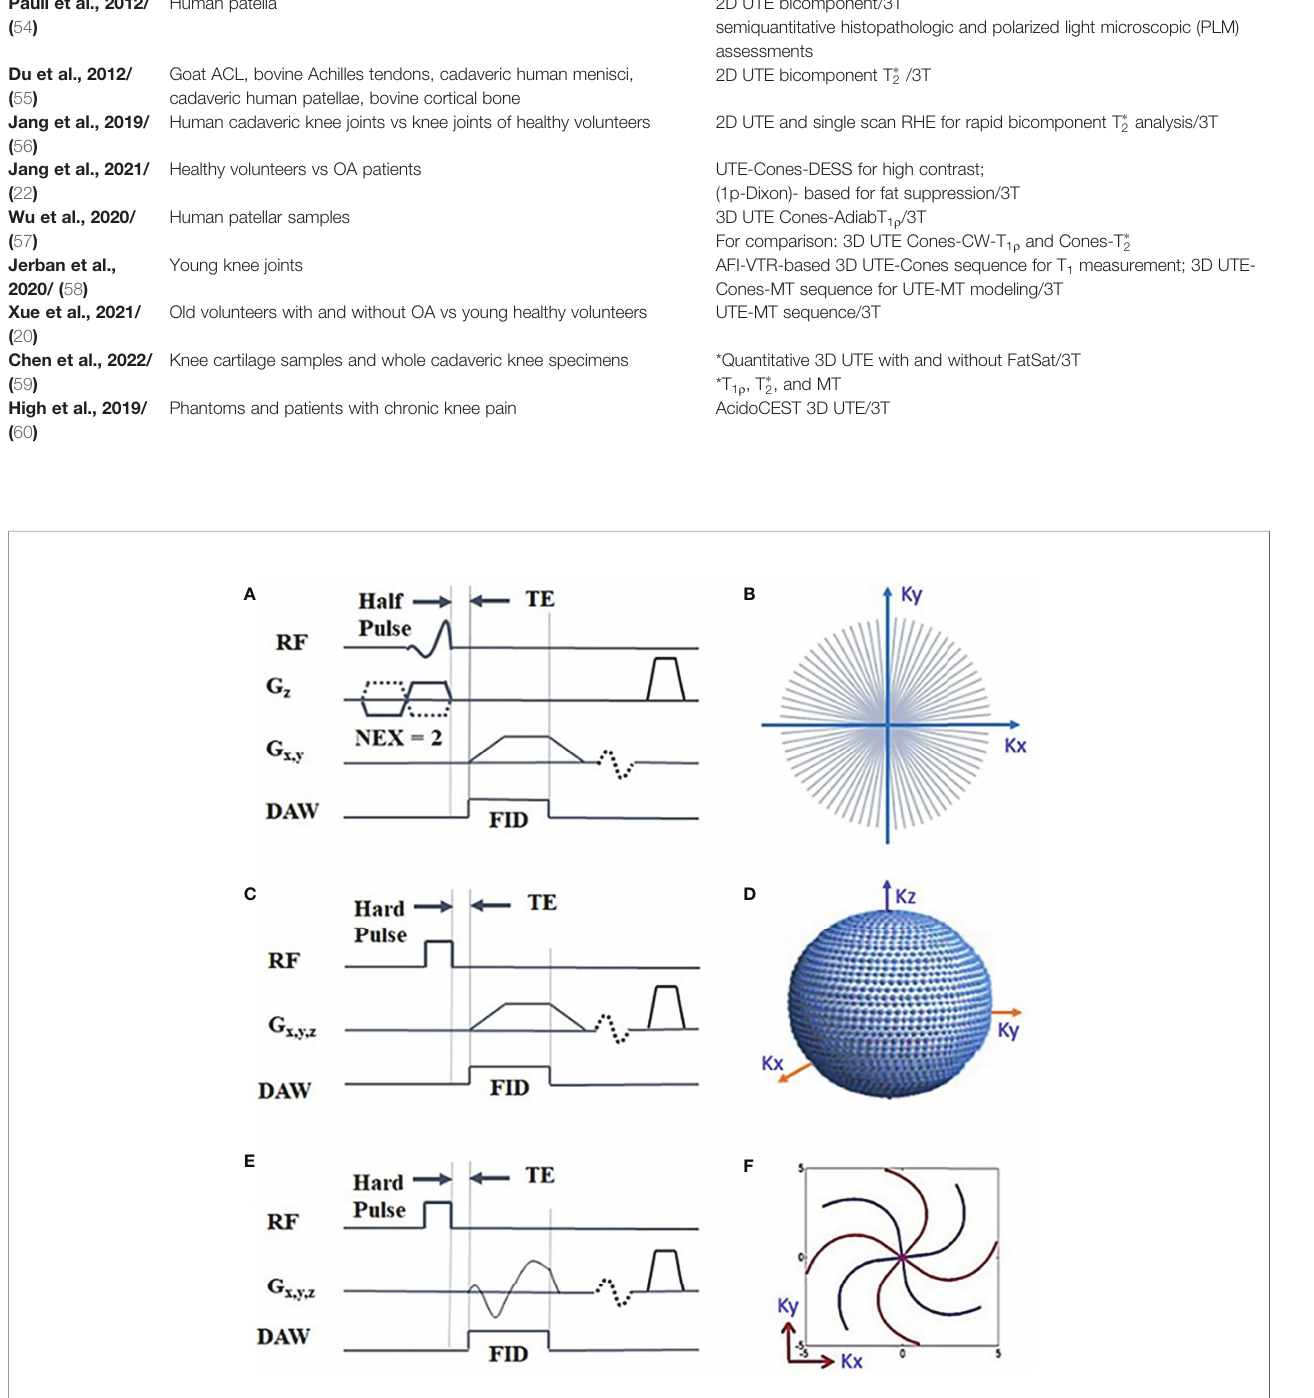
FIGURE 2 | Three representative UTE pulse sequence diagrams: 2D UTE sequence with a slice-selective half radiofrequency (RF) pulse excitation followed by 2D radial ramp sampling (A) (4), and 3D UTE with a short hard pulse excitation followed by 3D radial ramp sampling (C) (4) or by twisted radial trajectories with conical view ordering (4, 31) (33, 62) (E) . The k-space sampling patterns are shown in (B, D, F) , respectively. The data acquisition window (DAW) covers part of the free induction decay (FID) before the short T 2 transverse magnetization decays to near zero. Modi fi ed, with permission from Refs (4,